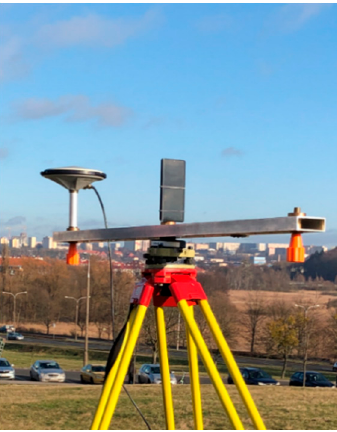
Figure 4. Second test setup. Huawei P30 Pro mounted in vertical position.